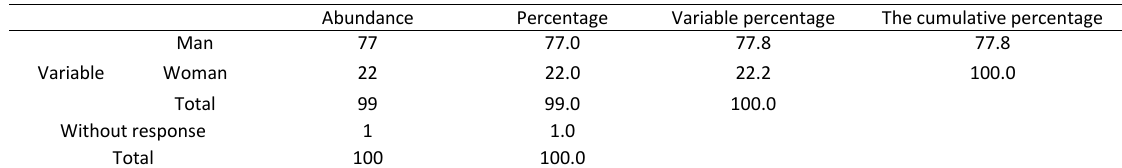
Table 5: Gender composition